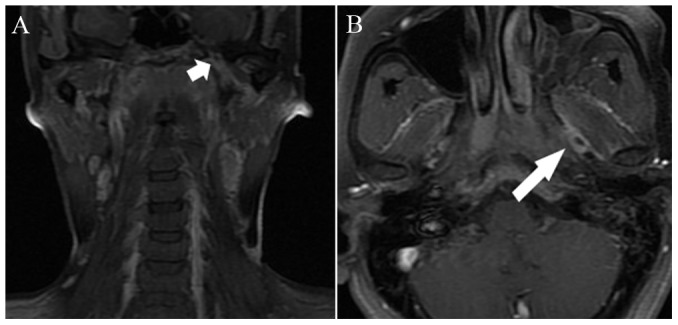
39-year-old woman with nasopharyngeal carcinoma with cranial nerve invasion: (A) enhanced coronal T1-weighted image with fat suppression shows the enlarged left foramen ovale with abnormal enhancement (short arrow); (B) the enhanced axial T1-weighted image with fat suppression shows the enlargement and abnormal enhancement of cranial nerve V3 (long arrow).